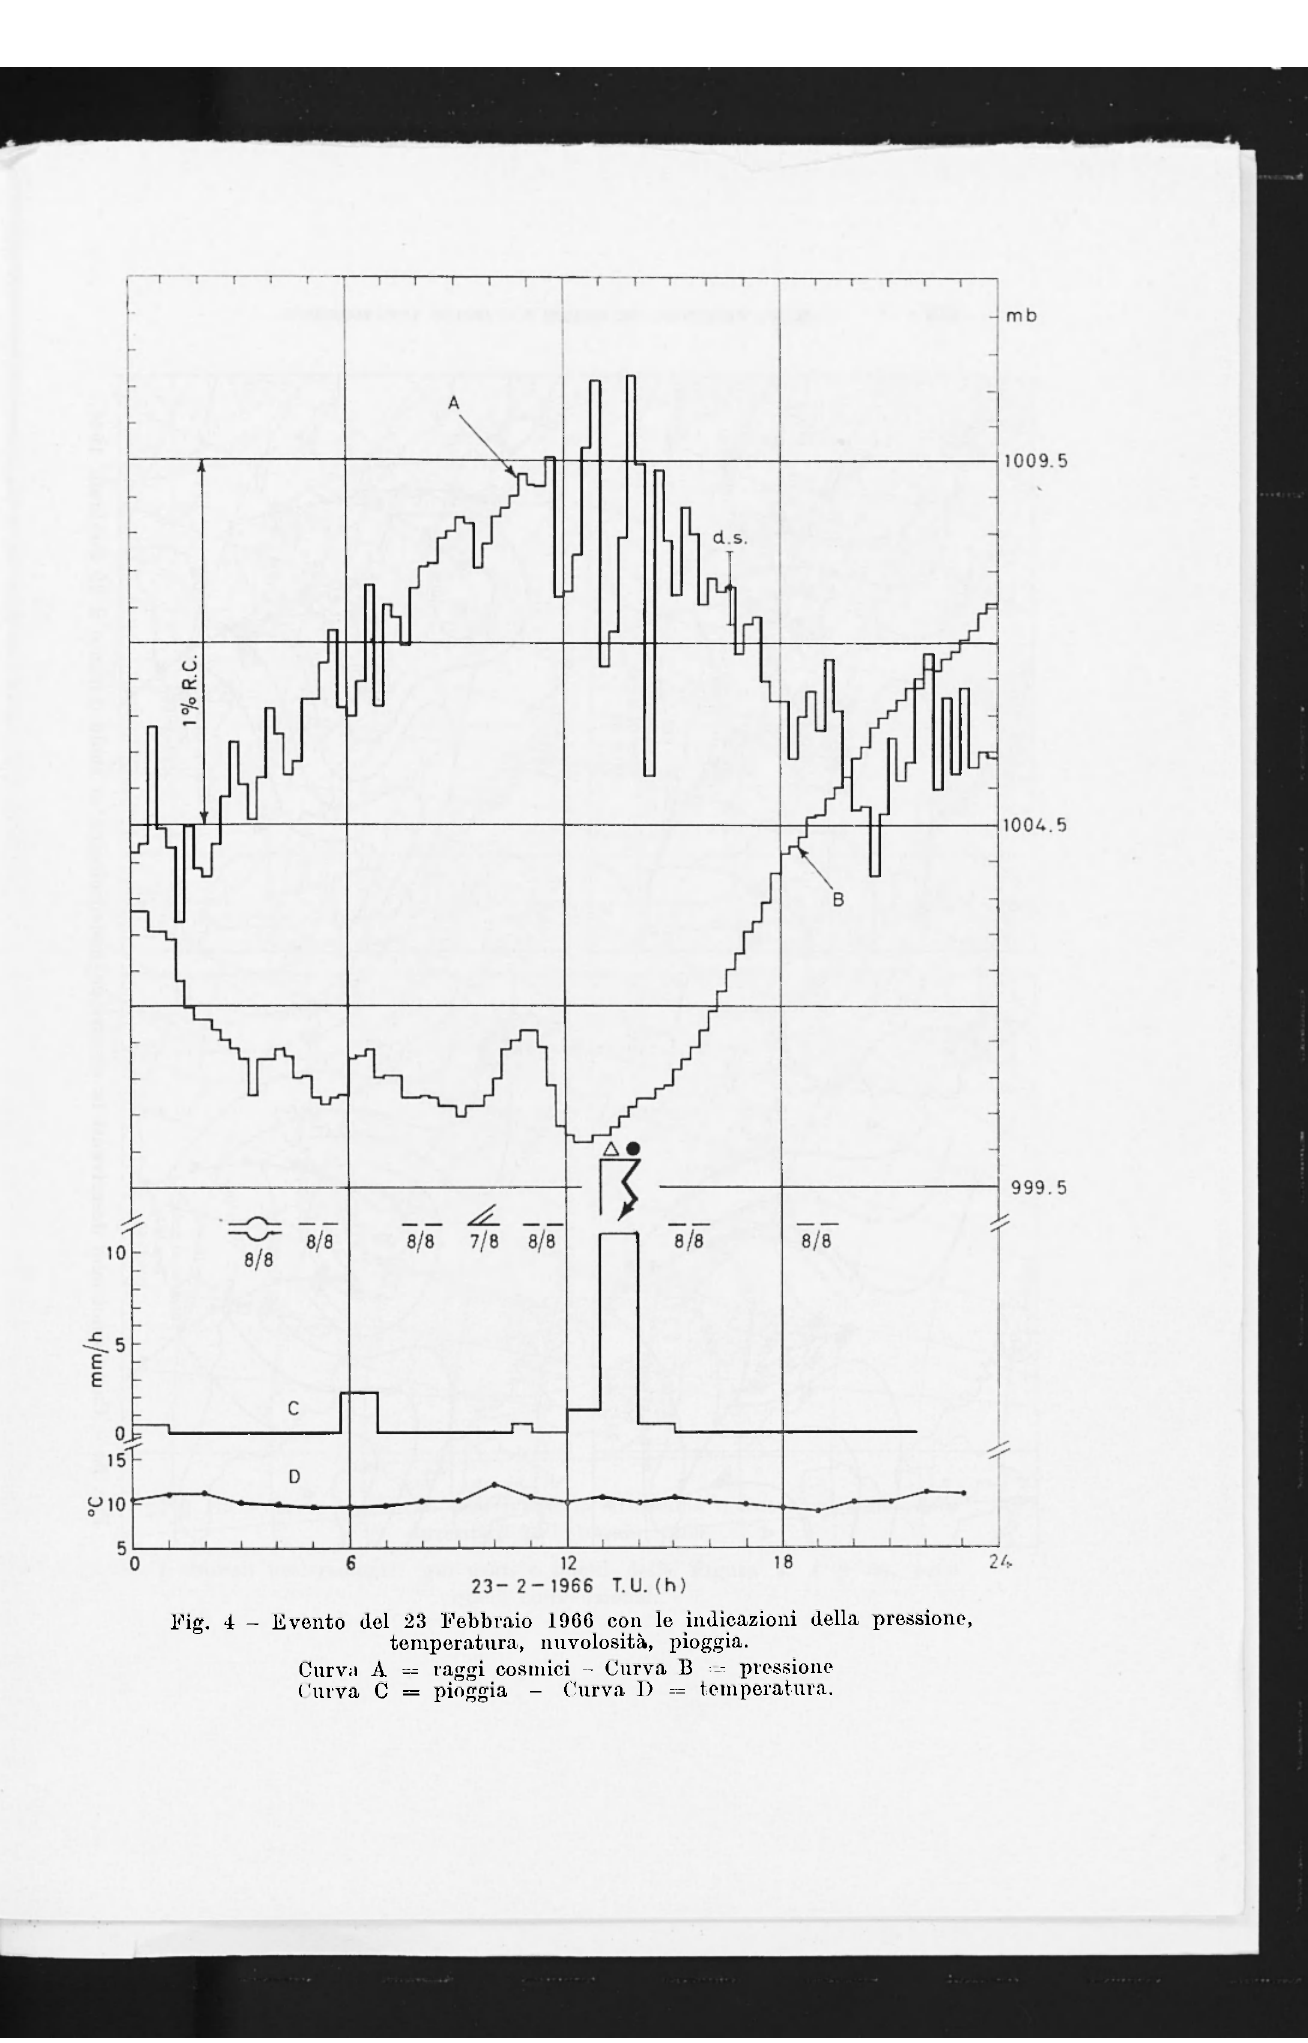
Fig. 4 - Evento del 23 Febbraio 1966 con le indicazioni della pressione, temperatura, nuvolosità, pioggia. Curva A = raggi cosmici - Curva B = pressione Curva C = pioggia - Curva D =